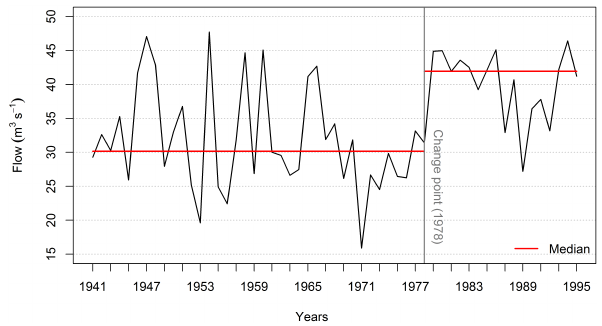
Figure 1. Observed annual mean flows in the Boyne for 1941–1995. Solid red line is the median of the period before and after the 1978 change point detected by Kiely (1999).